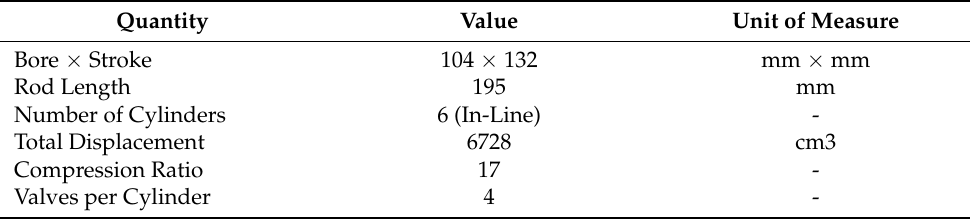
Table 1. Engine geometrical data.